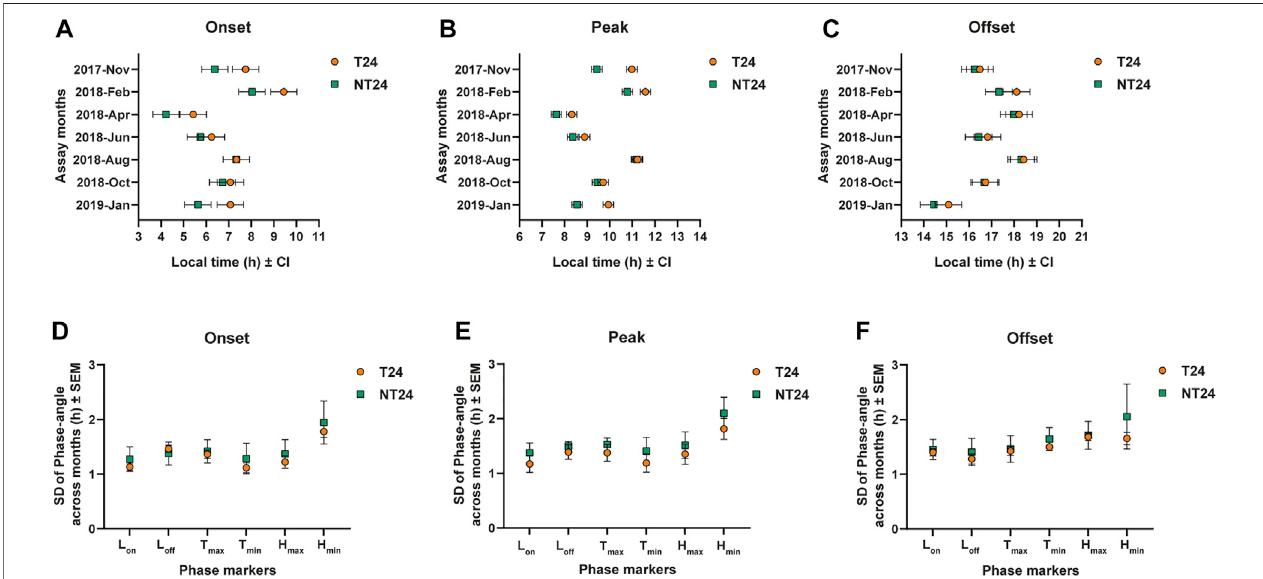
FIGURE 4 | Phasing of the eclosion rhythm under semi-natural conditions and phase-angle variation. (A) Average phase of Onset: Three-way ANOVA, Selection , Month , Selection × Month ; p < 0.05, Error bars: 95% CI via Tukey ’ s HSD (signi fi cant for Selection × Month ). (B) Average phase of Peak: Three-way ANOVA, Selection , Month ; p < 0.05, Error bars: 95% CI via Tukey ’ s HSD (signi fi cant for Selection ). (C) Average phase of Offset: Three-way ANOVA, Selection , Month ; p < 0.05, Error bars: 95% CI via Tukey ’ s HSD (not signi fi cant for Selection ). Variation in phase angle across months for phase markers of environmental variables viz. Lights On (L ON ), Lights Off (L OFF ), Maximum temperature (T MAX ), Minimum temperature (T MIN ), Maximum humidity (H MAX ) and Minimum humidity (H MIN ) for (D) average phase of Onset (E) average phase of Peak (F) average phase of Offset; Two-way ANOVA, p > 0.05 for Selection .